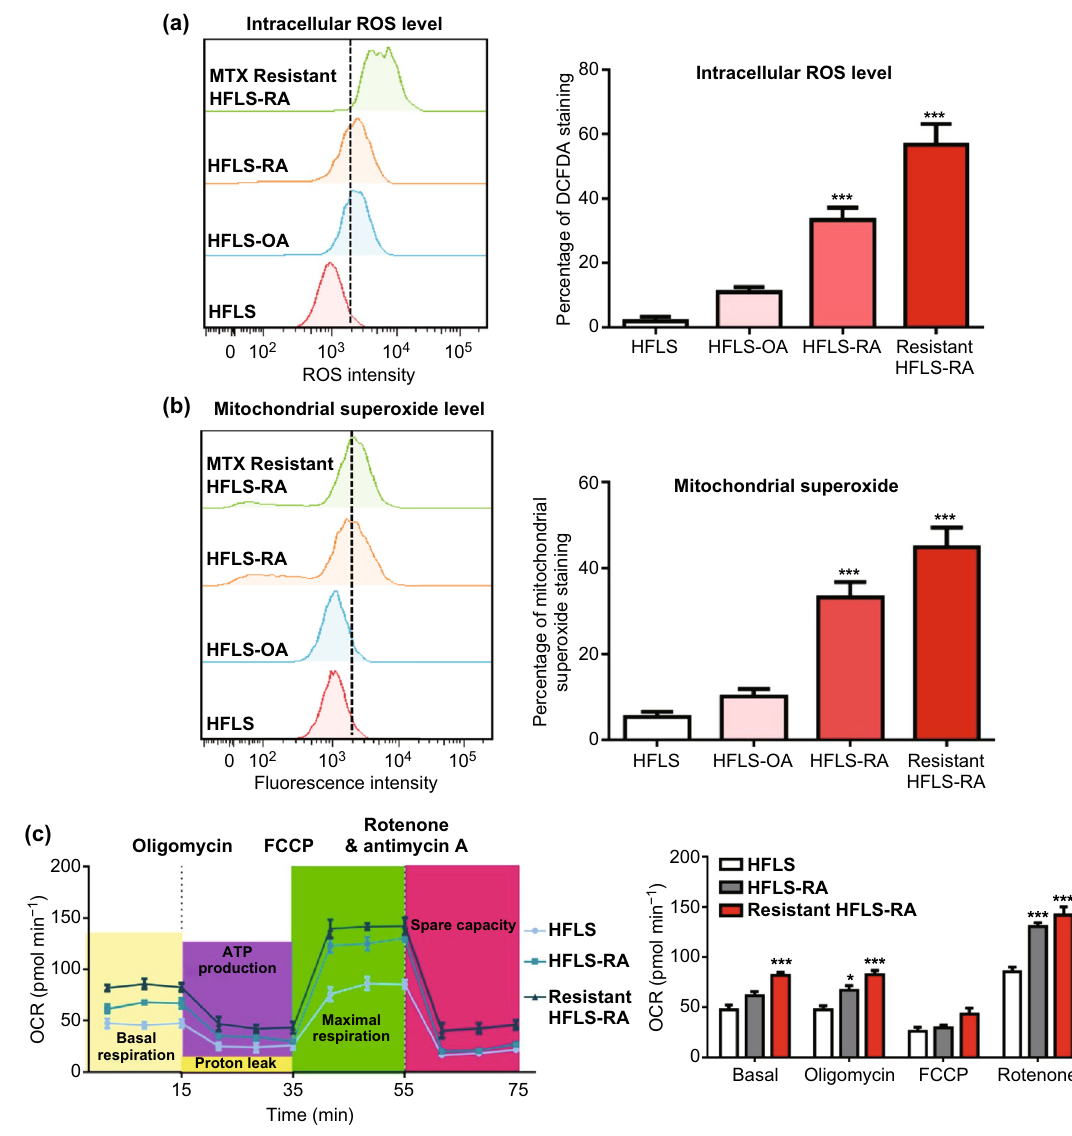
Fig. 1 ROS level is associated with the progress of RA. a , b ROS and mitochondrial superoxide levell were detected and compared in MTX‑ resistant, RA, OA, and normal synovial fibroblast. c OCR was evaluated in MTX‑resistant HFLS‑RA, HFLS, and HFLS‑RA. Data were ana‑ lyzed as the mean ± SEM for triplicate individual experiments (* P < 0.05, ** P < 0.01, *** P <